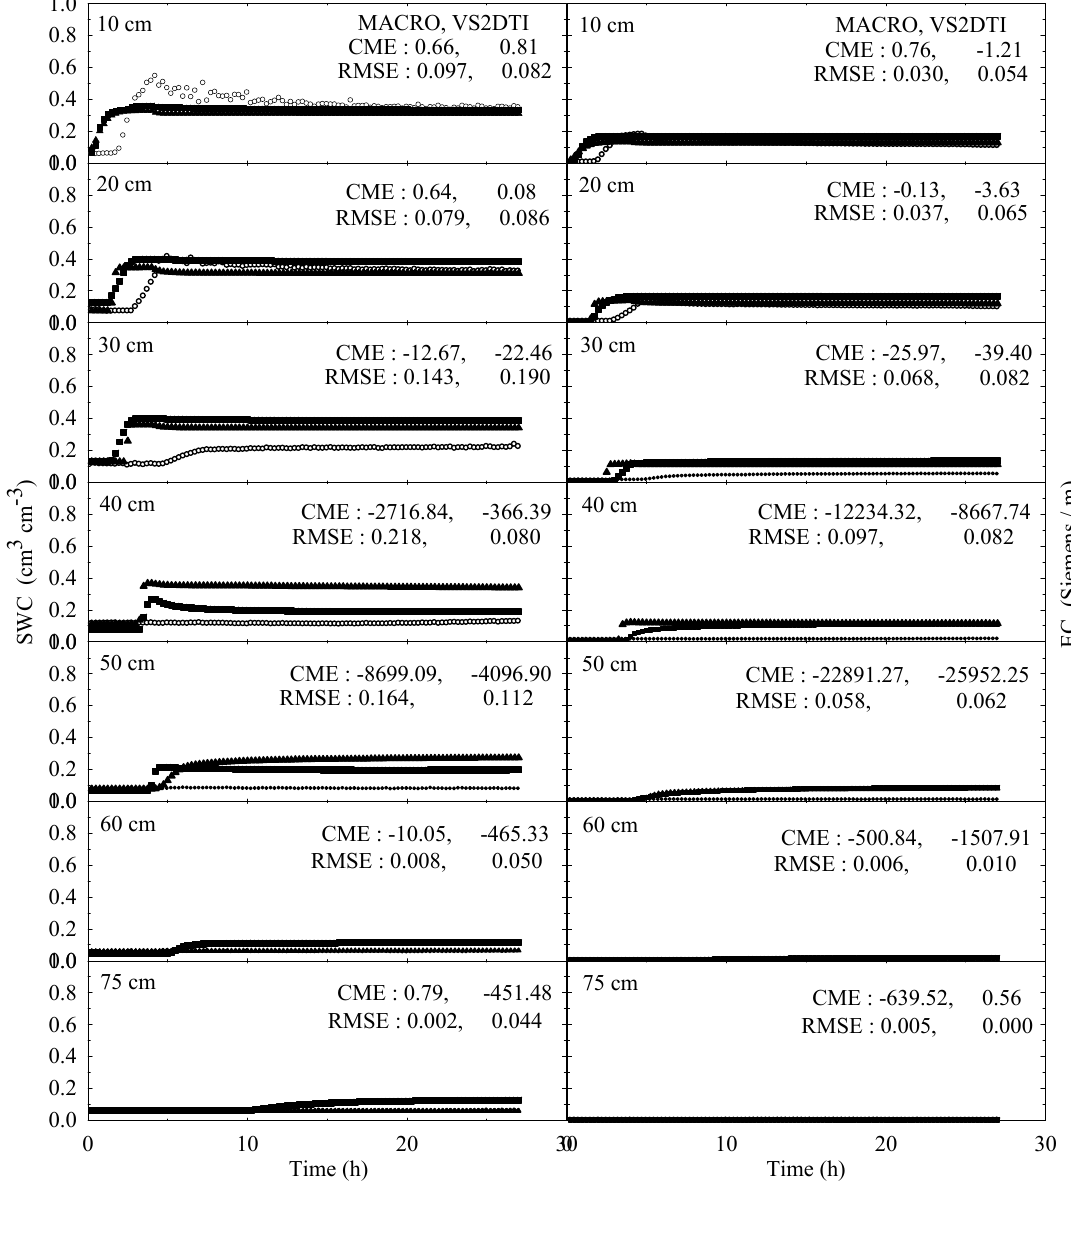
Figure 2. Spatial and temporal variability of soil water content (SWC) and electrical conductivity (EC) in the treatment of Sandy loam + Undisturbed + Dry + Low. The symbols of ○ , ▲ , and ■ represent the measured and model (MACRO and VS2DTI) values, respectively. CME and RMSE are the coeficient of model efficiency and the root mean square error, respectively.